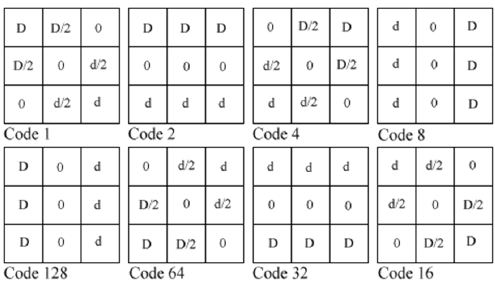
Figure 6 . Patterns according to the code. Figure 7 concerns two examples of pattern configuration in the case of a 5 × 5 moving window. In this case, D corresponds also to the value of difference added to A C , 3D/4 is equal to D × 0.75, D/2 to D × 0.5 and D/4 to D × 0.25; as previously d , 3d/4 , d/2 , and d/4 are negative values.